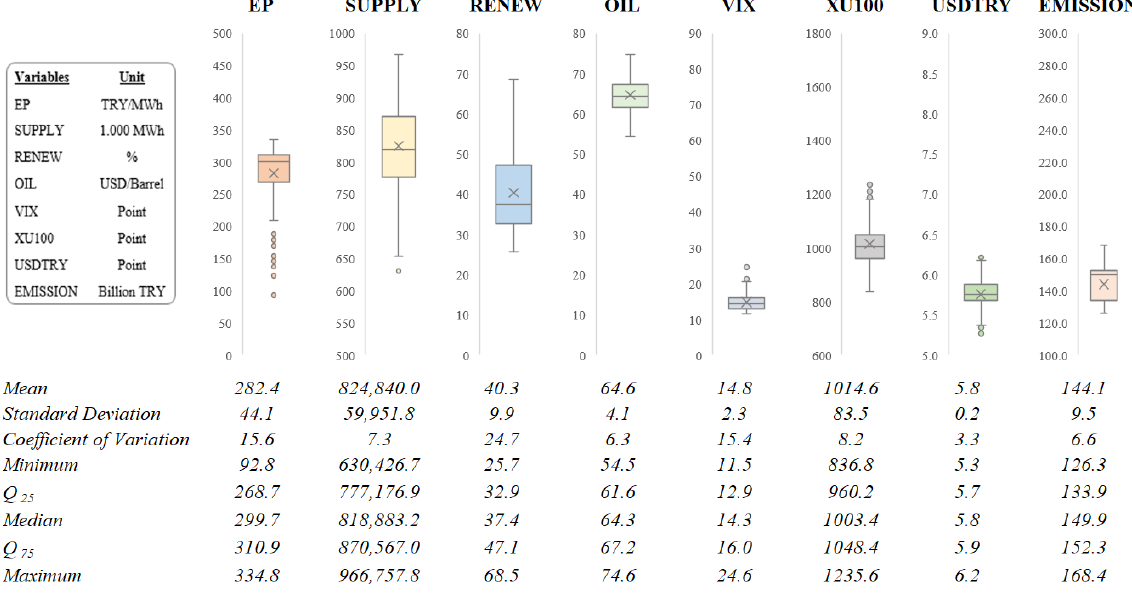
Figure 3. Descriptive statistics in the pandemic period (11 March 2020 –31 March 2021) . As presented in Figure 3, contrary to the pre- pandemic period, the number of outliers in electricity price, renewable electricity, oil prices, and the volatility index was relatively higher in the pandemic period, which states that the volatility of the aforementioned fac- tors increased . The standard deviations and variations relative to the mean were all above their pre-pandemic levels, reflecting the increased uncertainty due to the pandemic. Fur- thermore, the average values of the oil prices, volatility index, stock market index, foreign exchanges, and CBRT emission amount in the pre -pandemic period significantly changed in the pandemic period, while the average value of electricity prices stayed stable at the 280–209 level. This descriptive finding is strong evidence that the factors that influence the electricity price should be examined as separate periods for the pre -pandemic and pandemic periods.